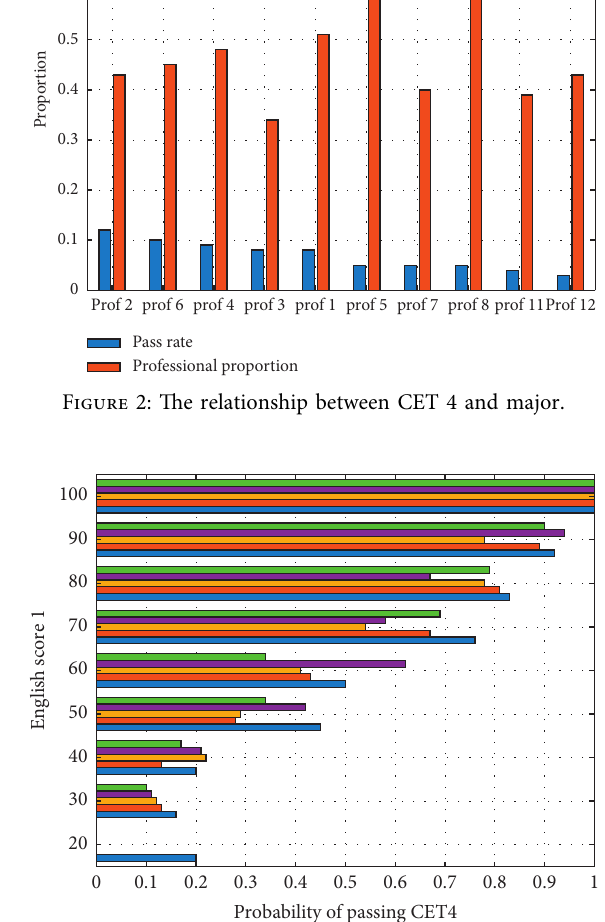
Figure 3: The relationship between CET-4 and College English 1.